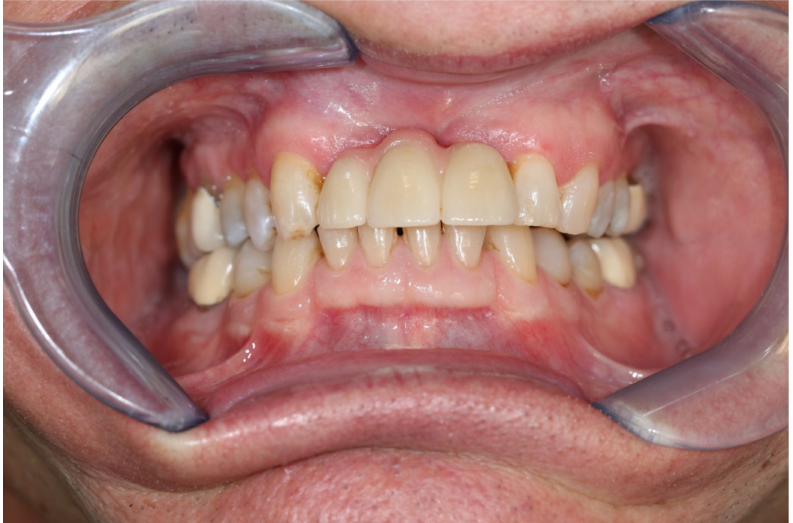
Figure 10. Oral situation after 2 years with prosthetic